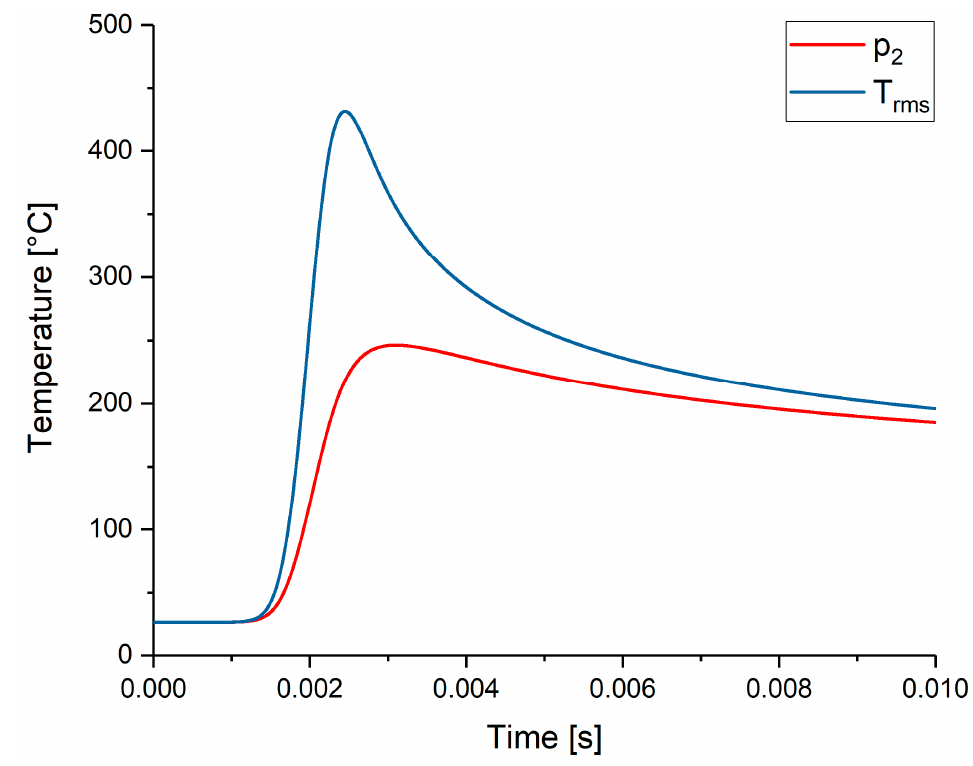
2 , T rms and T solder.